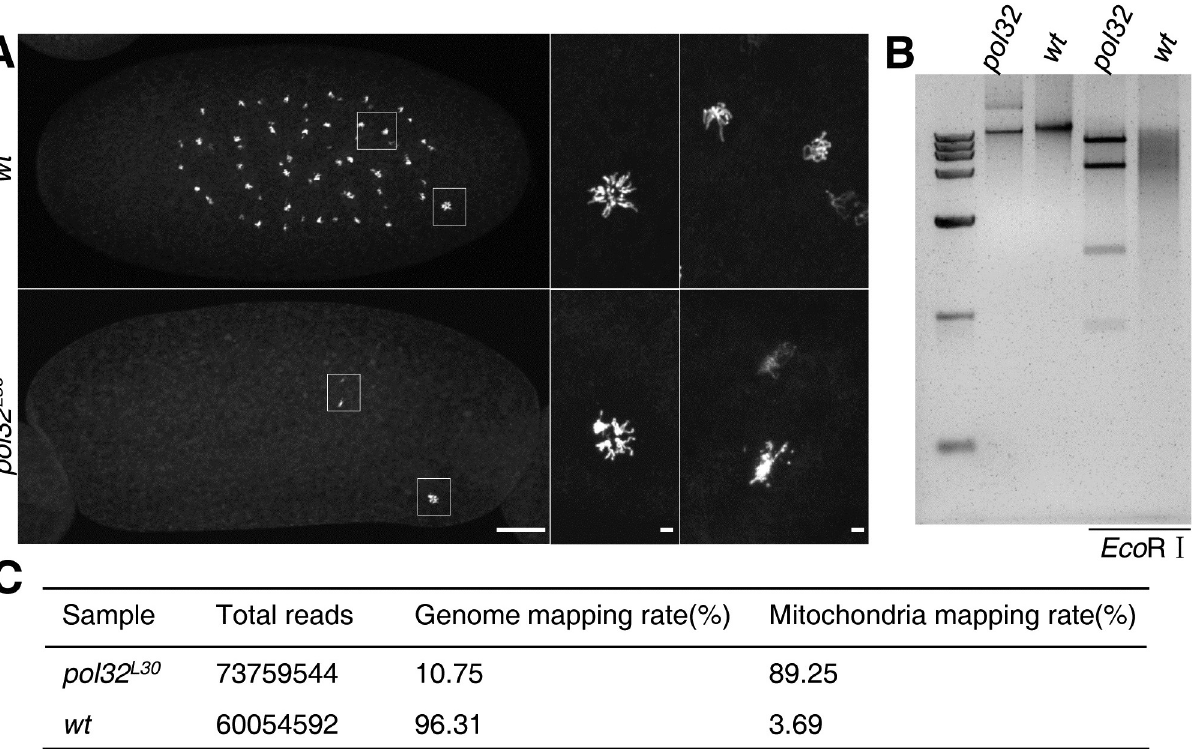
Fig 1. Loss of Pol32 impedes genomic replication. A . DAPI stained embryos of wild-type and pol32 mutants. These are embryos collected at 0-2hr after egg laying. Two areas of enlargement marked with rectangles are shown in the middle and the right panels, with the middle ones showing the polar bodies and the right ones showing zygotic nuclei. B . Agarose gel showing total embryonic DNA from mutant ( pol32 ) and wild-type ( wt ) embryos either uncut (left two lanes) or cut with Eco RI (right two lanes). The markers in the leftmost lane, from top to bottom, have sizes in kb of: 15, 10, 7.5, 5, 2.5, 1, 0.25. C . Summary results from whole genome sequencing showing DNA from pol32 mutant embryos primarily consists of mitochondrial DNA. Scale bars indicate 40 μ m.